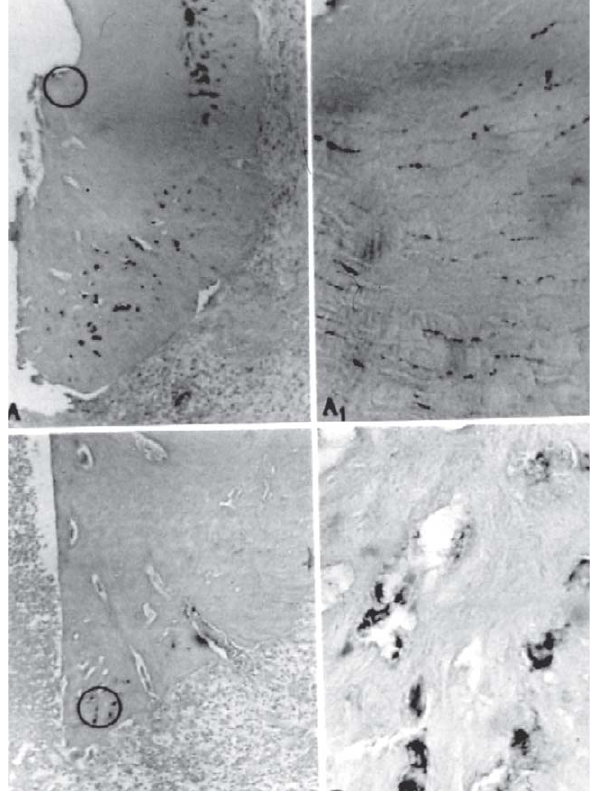
FIGURE 2- Group II: A- Innumerable cementum lacunae and dentinal tubules (circle) containing microorganisms. 125x. A1- Propagation of gram-positive cocci through dentinal tubules – 1000x. B- Microorganisms in the cementum lacunae (circle) and canals of the apical delta– 125x. B1- Gram-positive and negative cocci and bacilli in cementoplasts – 1000x. Brown & Brenn